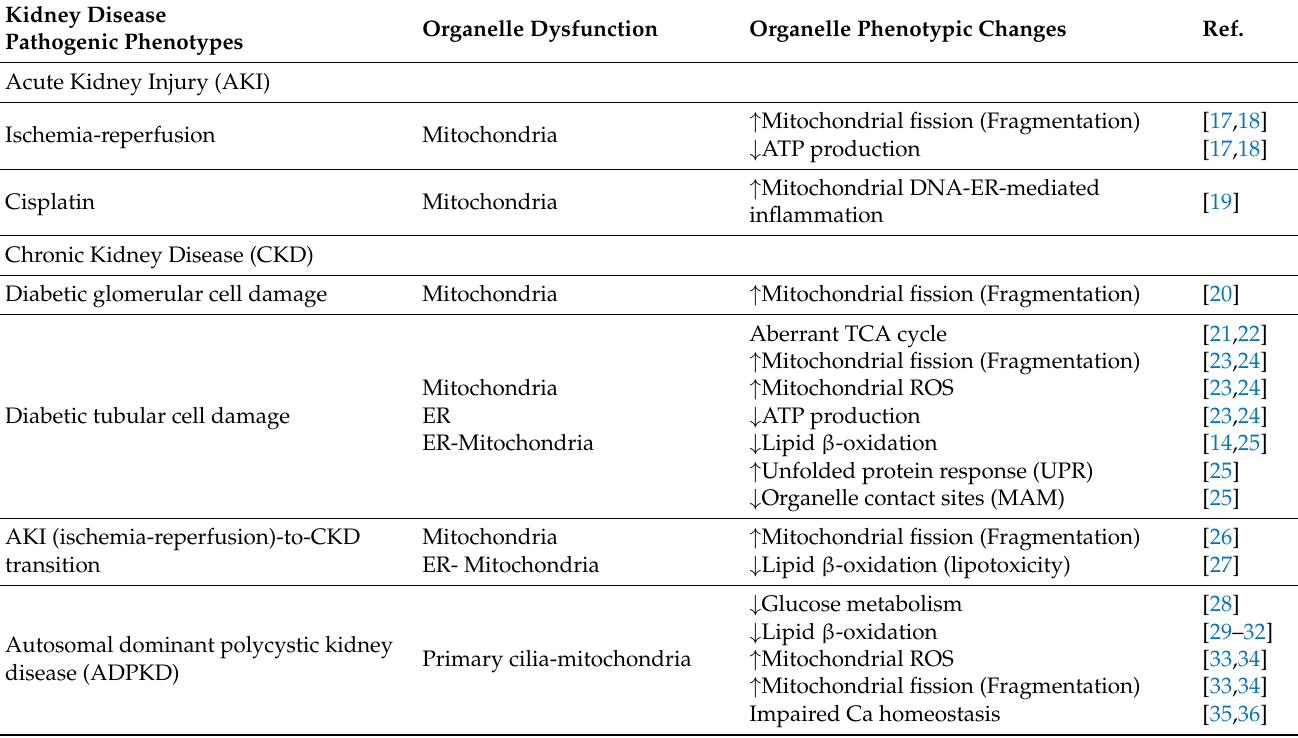
Table 1. Organelle stress and its phenotypic changes in kidney